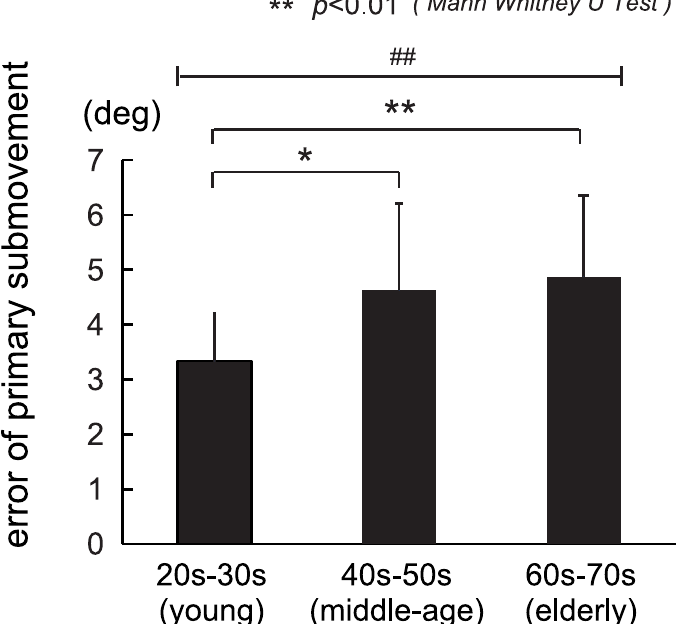
Fig 4. Age-related changes in errors following the primary submovement. The error of the primary submovement was measuredas the distancebetweenthe starting point of the primary submovement and the target. Note that the error in the young group (20–30years old) was significantly shorter than that in the other age groups, suggestingthat the younggroup showedbetter performance in primary submovement than the middle-age and elderly groups, and that the accuracy of primary submovement was poorer for the aged groups.